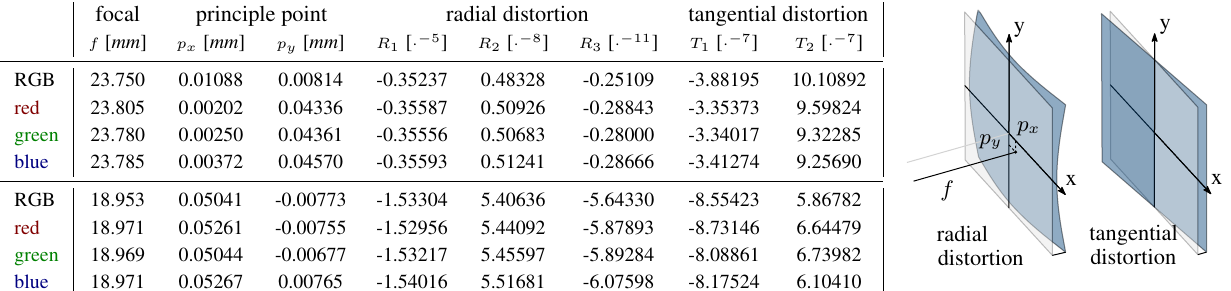
Table 3: Internal calibration estimations for different colorbands. The first half is rooted from the fixed-wing campaign, the second half is originated from imagery of the multi-rotor. The imagery on the right indicates the coordinate axis for the principle point and illustrates the different kind of distortions. The radial and tangential parameters should be applied to metric radial distance. Voigtl¨ander lens has far less radial distortion, in addition, its val- ues are more stable than for the other camera. The only exception is the principle point of the full color processing, which is out off sync with the other values, its not easily identifyable. No signif-